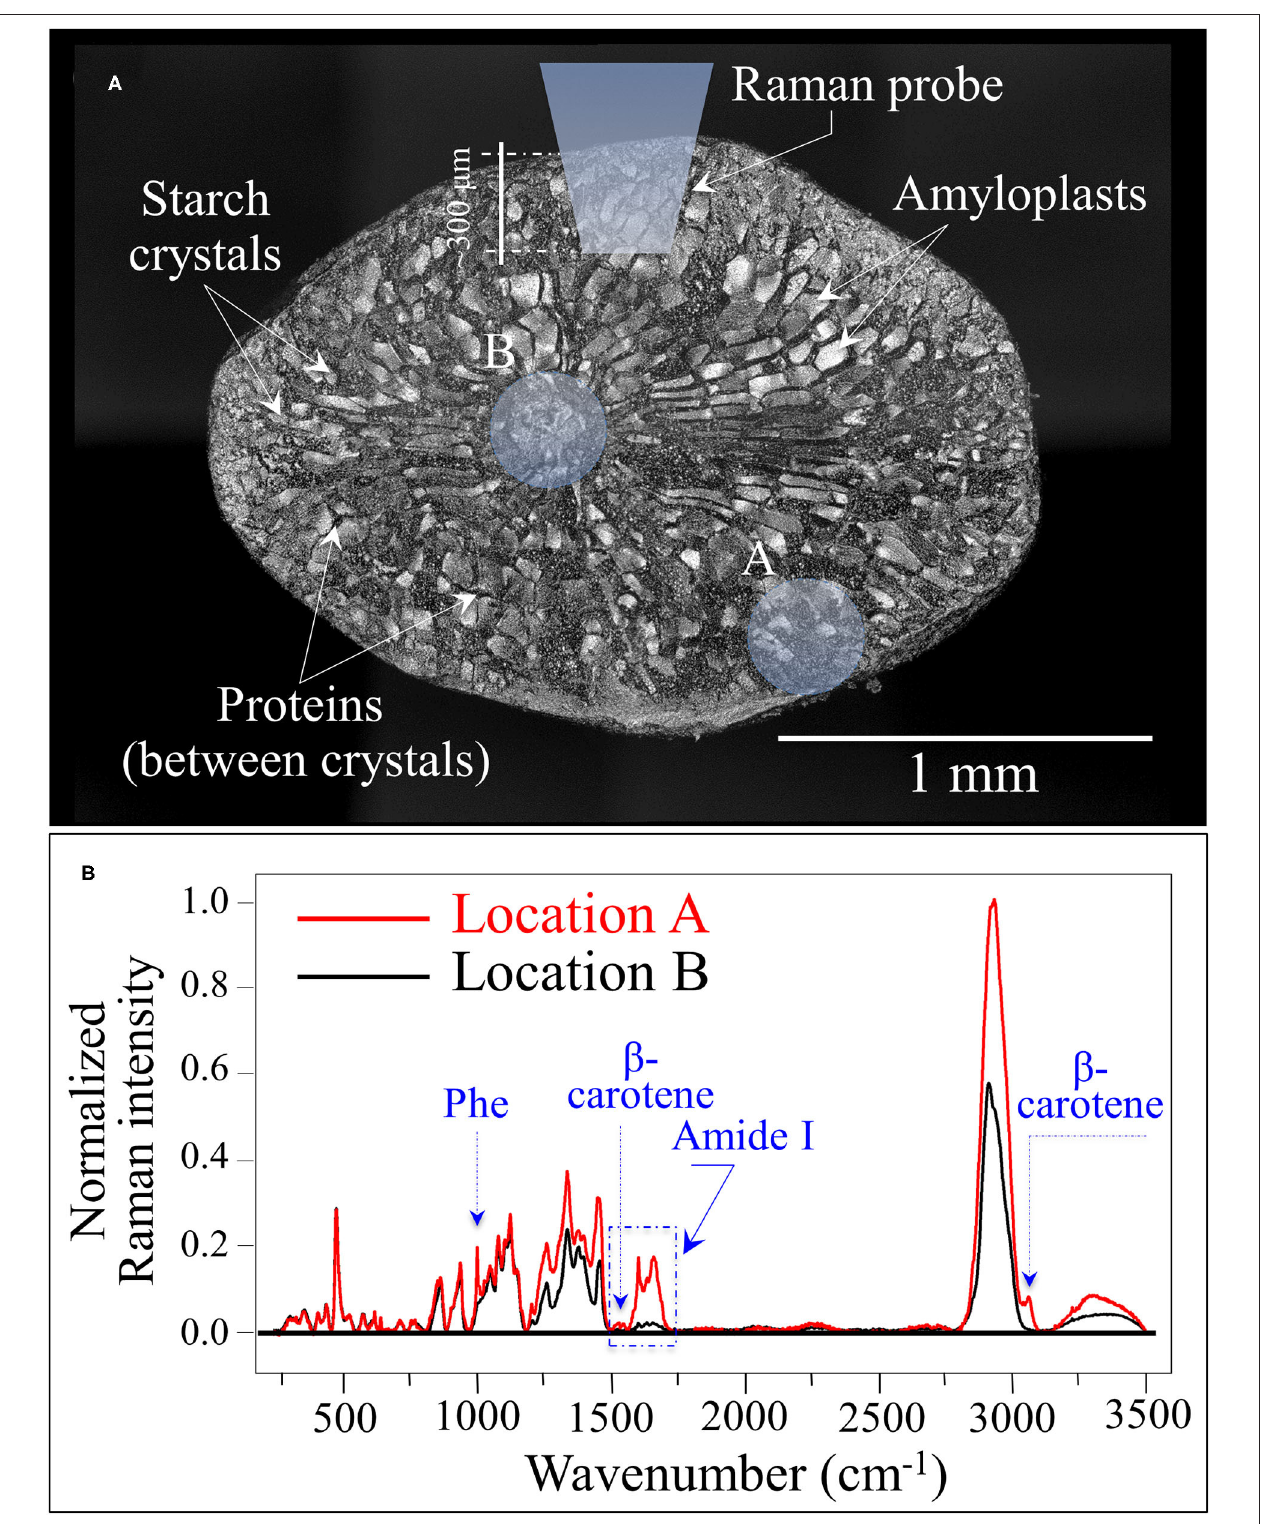
FIGURE 5 | (A) Laser micrograph (and structural features given in inset) of the cross section of a Koshihikari (Kyoto) rice kernel; the draft in inset schematically shows the laser penetration depth when the Raman measurement is non-destructively made. The two locations labeled as A and B produced the Raman spectra shown in (B) . The three main differences between spectra collected in A and B relate to phenylalanine and Amide I signal intensities, and to an additional band located at ∼ 3,070 cm − 1 [cf. labels in (B) ].